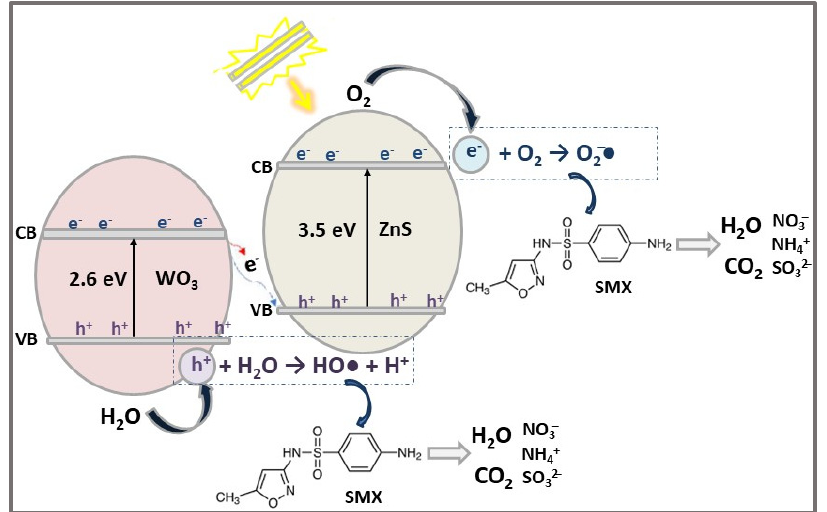
Figure 7. The photocatalytic degradation mechanism of SMX antibiotic using ZnS/WO 3 heterostruc- ture photocatalyst under Vis light irradiation for 1 h.